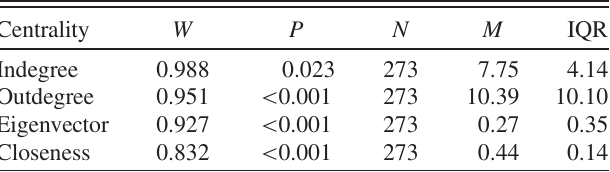
TABLE IV. Descriptive statistics for centralities. Based on the Shapiro-Wilk test (test statistics W and P values, columns 1 – 2), the null hypothesis about the normal distribution is rejected for all centralities. The median ( M ) and interquartile range (IQR) are used to describe the distribution and dispersion for each